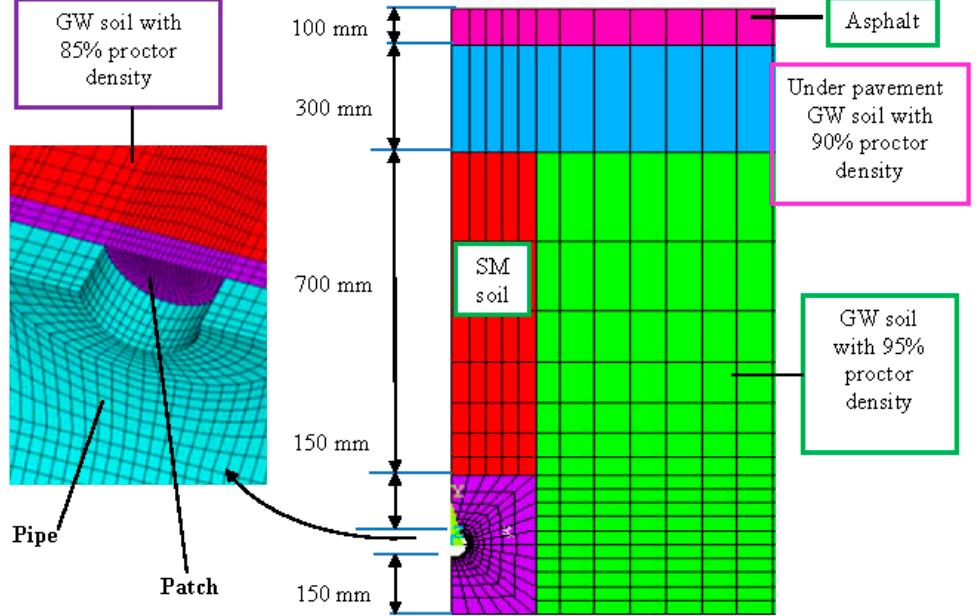
Figure 10. Finite element model of the patched pipe with surrounding soil subjected too internal pressure. GW: Well-graded gravels; SM: Silty sands [11].